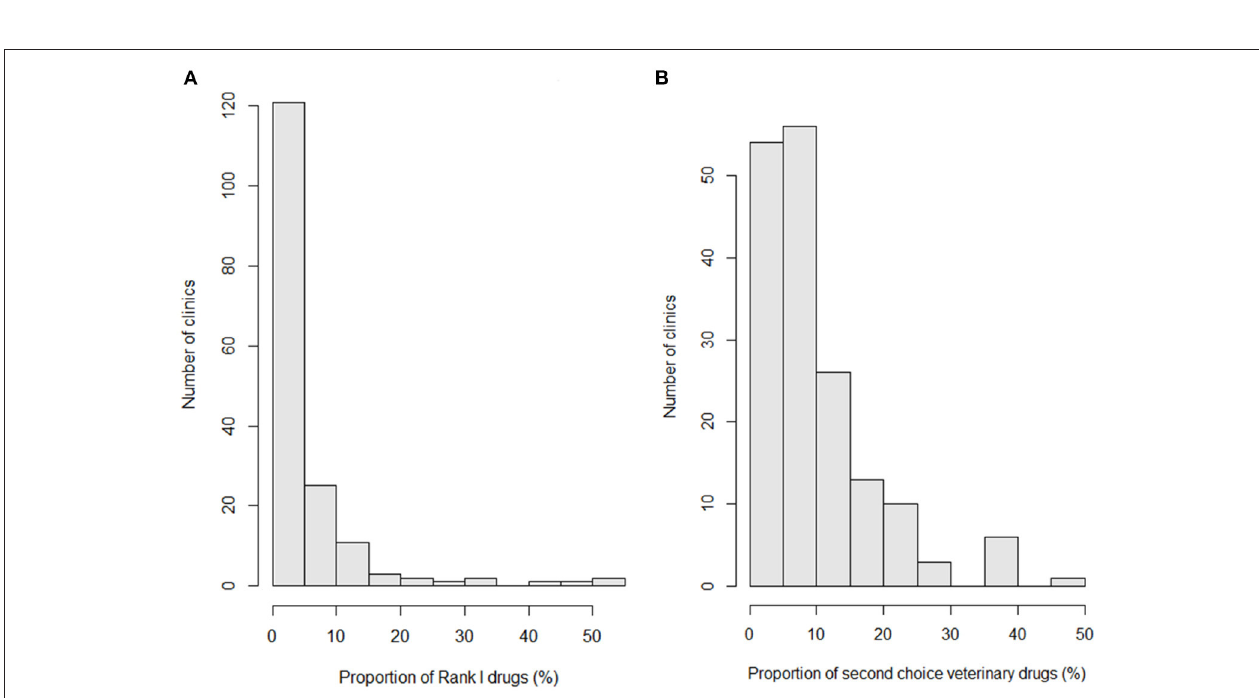
FIGURE 3 | Histograms indicating the proportions of rank I (A) and second-choice veterinary drugs (B) used at the studied clinics.